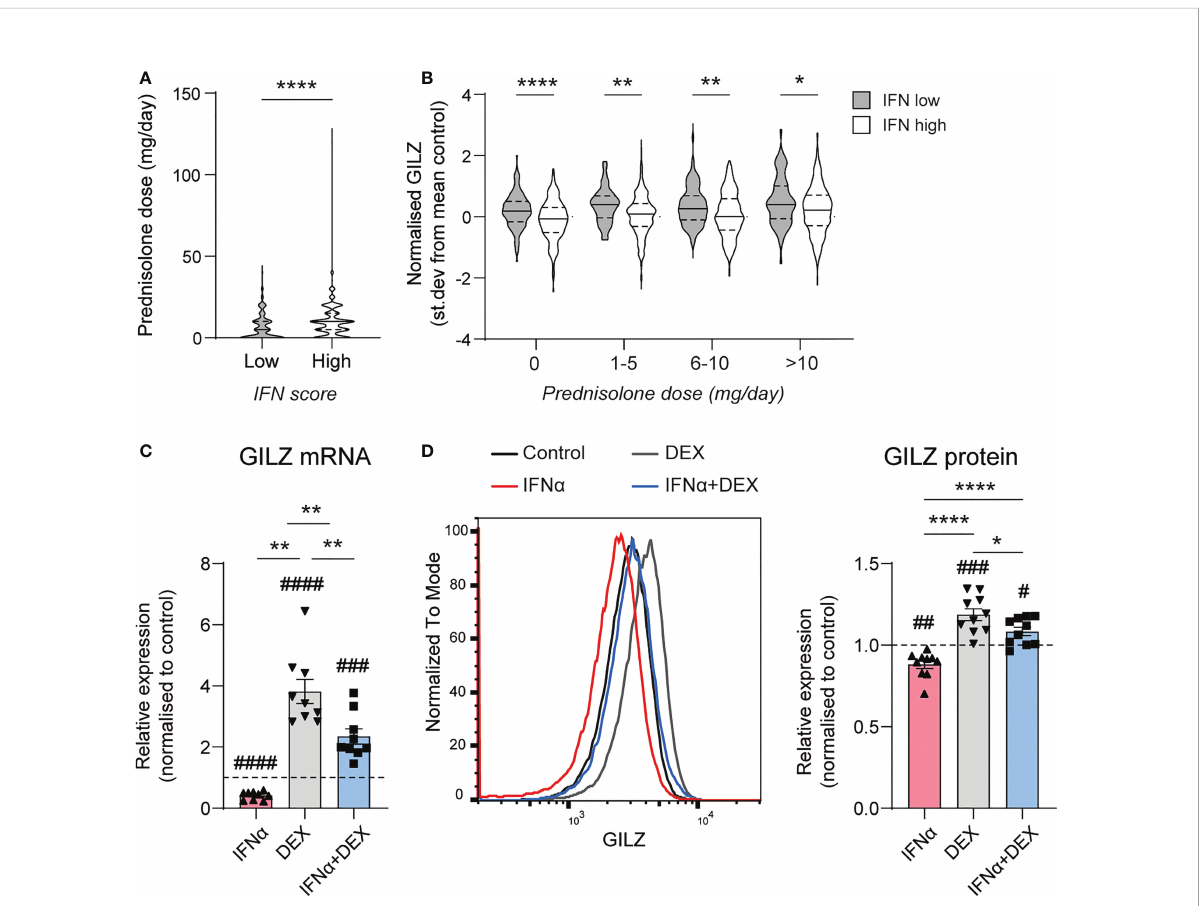
FIGURE 3 Type I IFN inhibits DEX-induced GILZ. (A) Daily prednisolone dose in SLE patients with low or high IFN score (GSE88884, n=1756). (B) GILZ expression in PBMC of SLE patients strati fi ed by daily prednisolone dose (GSE88884, n=1756). (C, D) Healthy PBMC were treated with IFN a , DEX or both, after which GILZ mRNA expression was analysed by qPCR (C) , and GILZ protein level was analysed by fl ow cytometry in the same samples (D) GILZ protein level is represented as MFI normalized against the control MFI for each donor. n=9, pooled from three independent experiments. *p<0.05, **p<0.01, ****p<0.0001. #symbol indicates signi fi cance of difference from control (untreated) cells, # p<0.05, ## p<0.01, ### p <0.001,